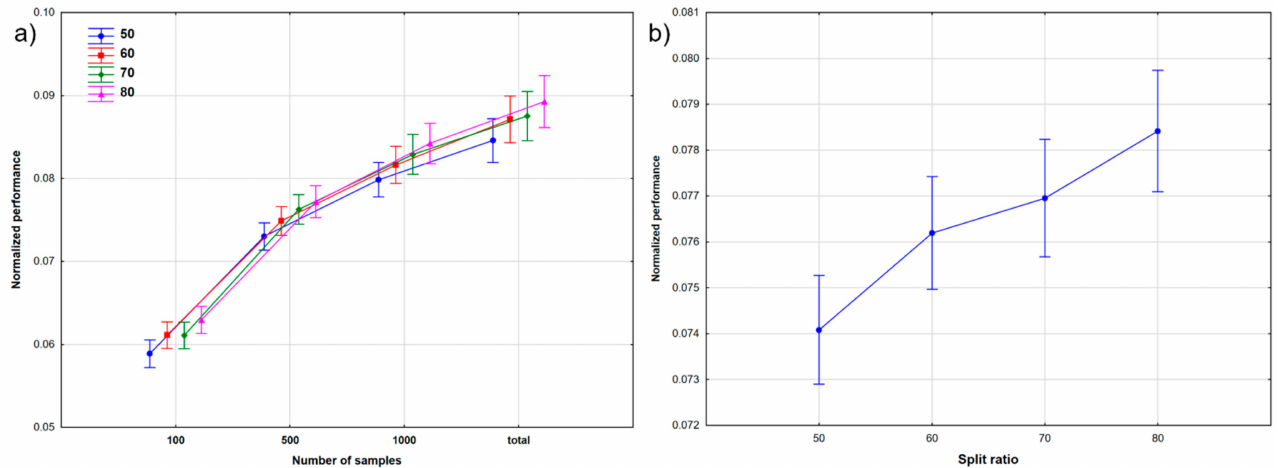
Figure 8. The effect of: ( a ) the number of samples (NS) at different split ratios, and ( b ) the split ratios (SR) on the performance of the models for Case Study